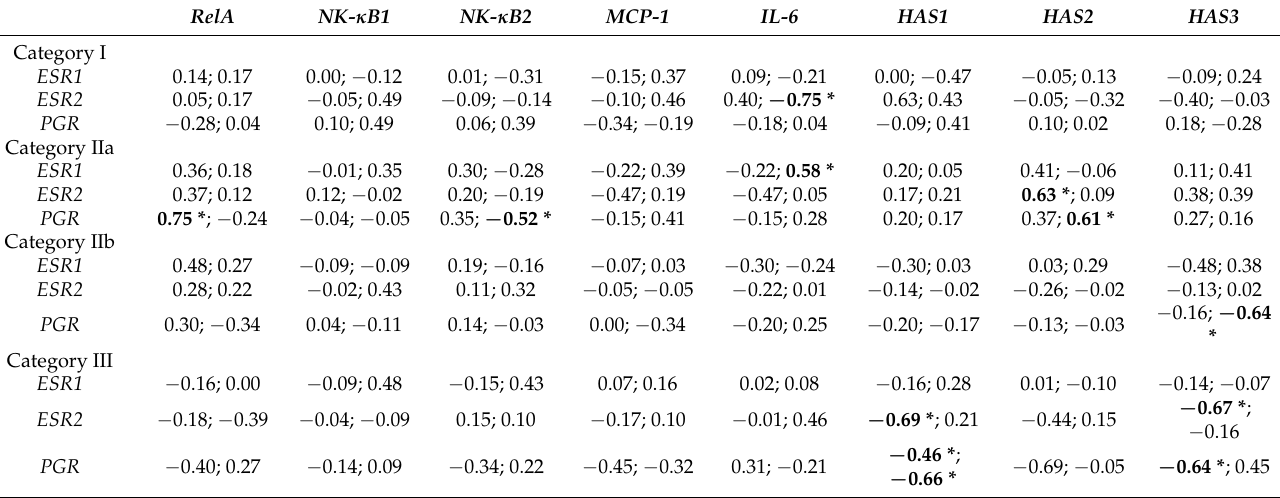
Table 1. Spearman’s correlation coefficient ( ρ ) between transcription levels of ovarian steroid recep- tors ( ESR1 , ESR2 , PGR ) and transcription levels of selected proteins of the nuclear factor κ B (NF- κ B) signaling pathway ( RelA , NK- κ B1 , NK- κ B2 , MCP-1 , IL-6 , HAS1 , HAS2 , HAS3 ) in equine endometrium classified according to different categories (I, IIa, IIb, III). The value of ρ is reported for the follicular (FLP) and mid-luteal (MLP) phases of the estrous cycle. In one cell in the table, both ρ values are reported as ρ for FLP; ρ for